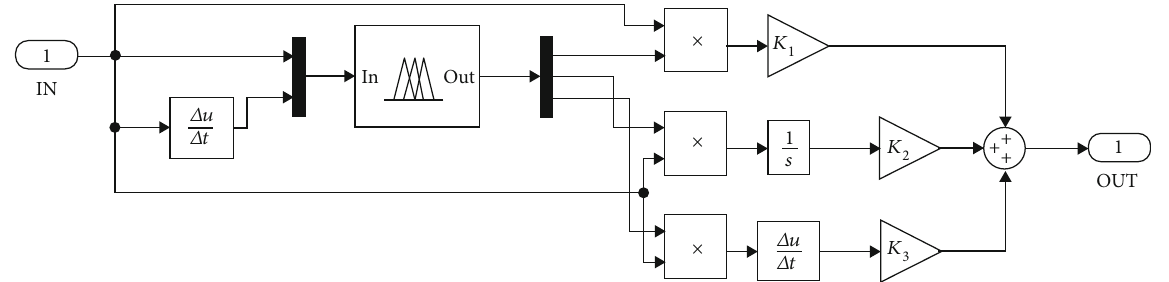
Figure 7: MATLAB Simulink model of the fuzzy PID